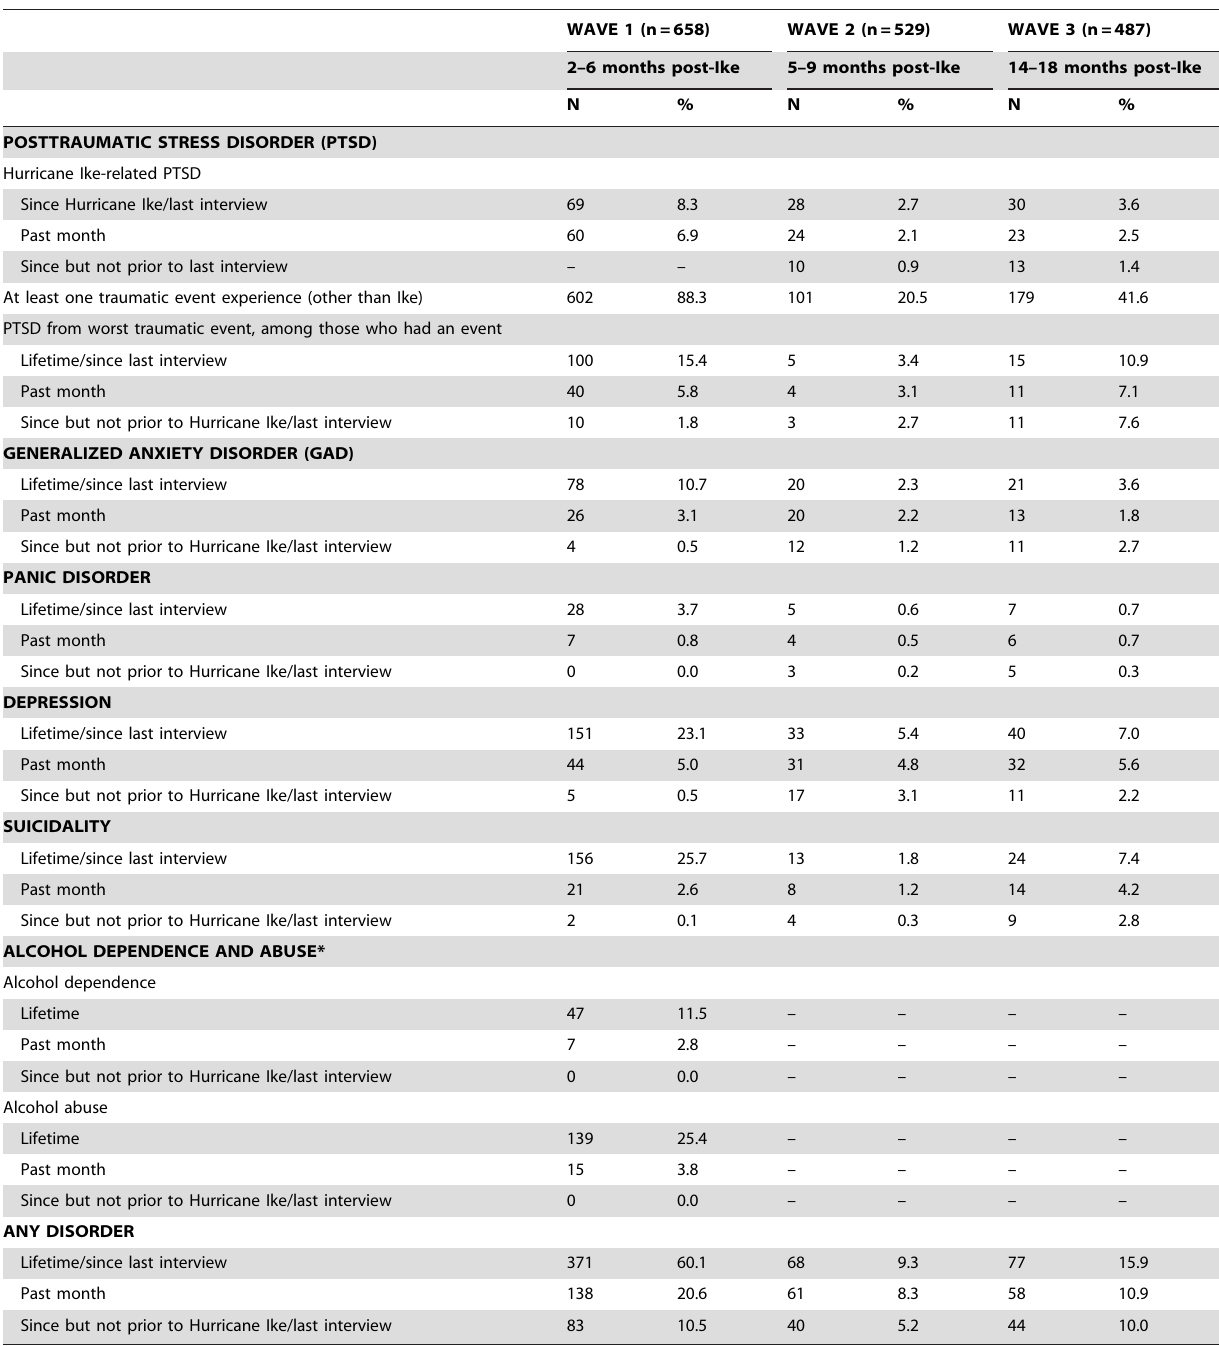
Table 2. Prevalence of mental health outcomes, by survey